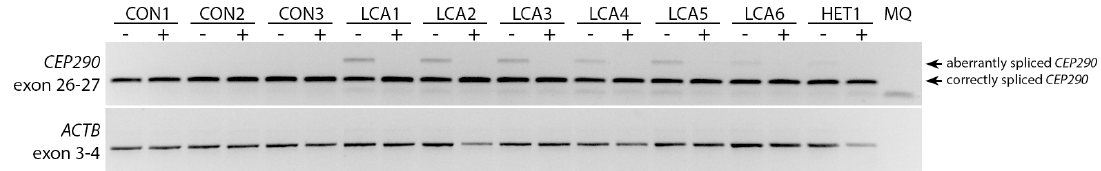
Figure 1. AON rescue at RNA level in all cell lines. RT-PCR analysis of CEP290 transcripts. The upper band corresponds to the transcript containing the 128-bp pseudoexon. The lower band is the correctly spliced transcript. In all cases that showed pseudoexon inclusion, the splicing was corrected upon AON delivery (+). In the lower panel, actin ( ACTB ) expression is shown as a loading control. Cell lines are indicated with CON (control), LCA (patient) and HET (carrier). MQ corresponds to the negative control of the PCR. ( − ) means untransfected cells.